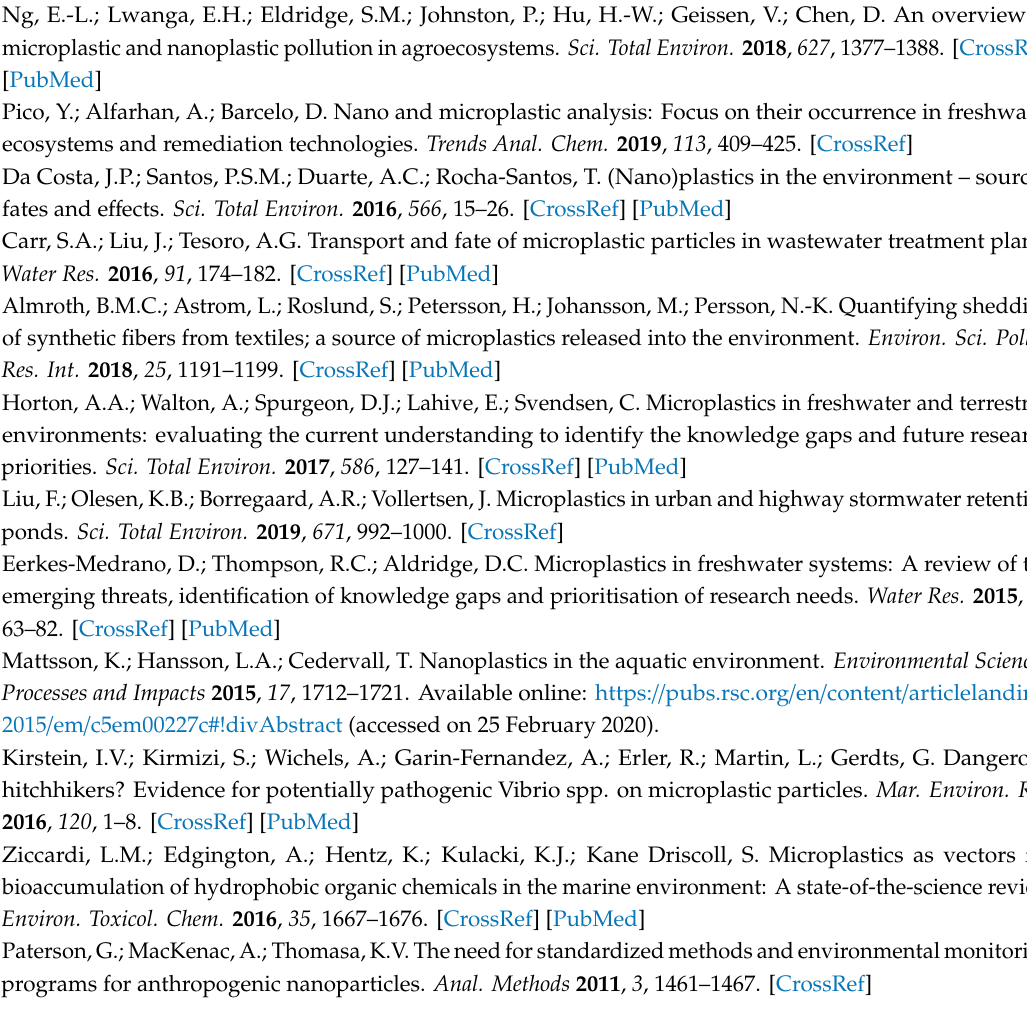
Table S1-1: Factorial Experiment for Ballast Flocculation (data), Table S1-2: 2 8-4 factorial design results and decoded design parameters for ballasted flocculation removal of nano-plastic particles, Table S1-3: ANOVA analysis of significant factors, Table S1-4: 2 8-4 factorial design results and decoded design parameters for ballasted flocculation removal of nanoplastic particles, insignificant parameters removed, Table S1-5 ANOVA analysis of significant factors for alum dose, mixing intensity, and coagulation time, Table S2-1 Steepest ascent values used to optimized ballasted flocculation, Table S2-2: Steepest ascent optimization of ballasted sand